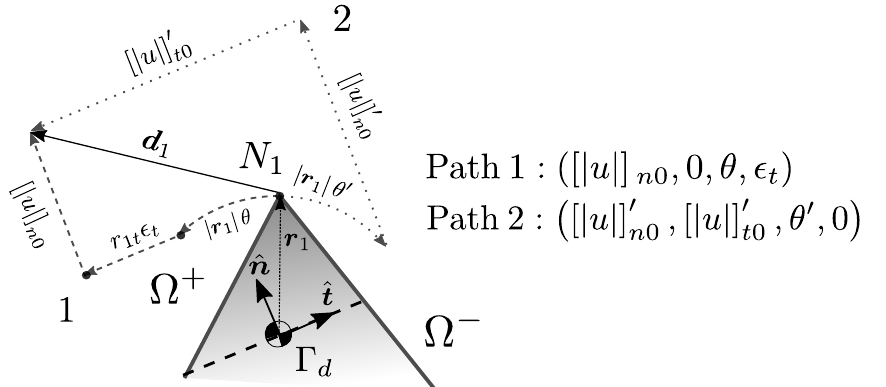
Figure 10. Illustration of linearly dependent kinematic mode decomposition for a CST having one single node on the Ω + domain. Two different paths using different values for the kinematic modes are portrayed. Both paths (and endless others) lead to d 1 in this